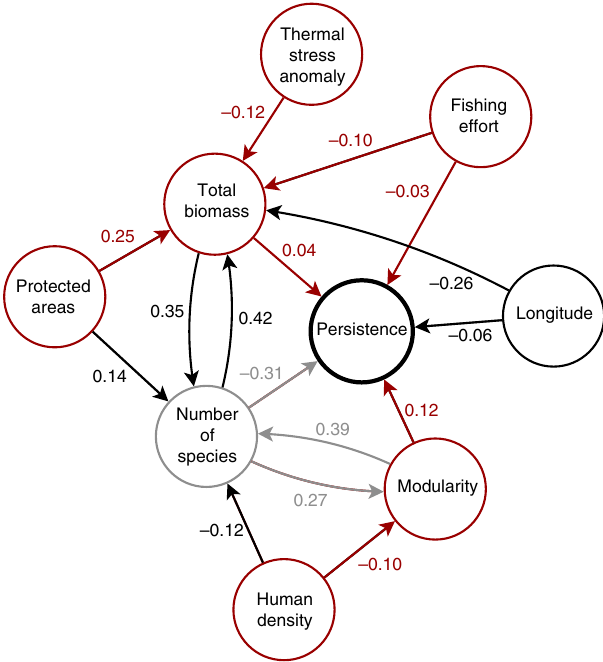
Figure 2 | Network of statistical associations between variables. Each link represents a statistically significant effect of one variable on another. The numbers next to each link are the effect sizes. The associations between anthropogenic effects and food-web persistence are represented in red. Light grey represent already expected relationships from a theoretical standpoint.